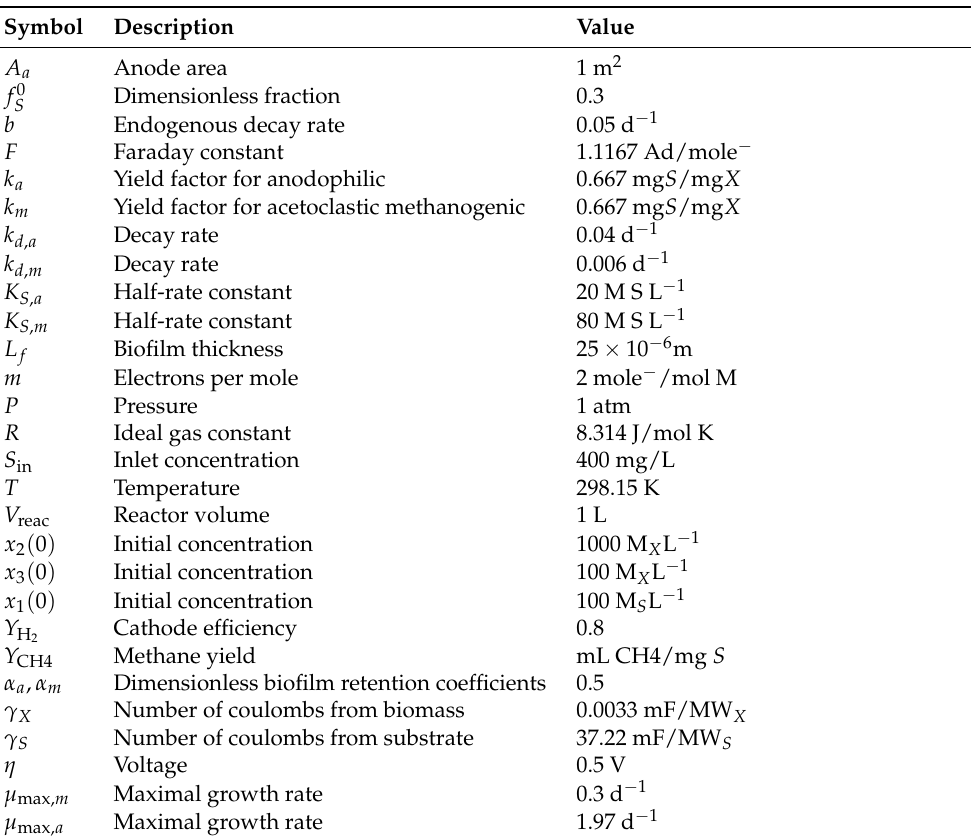
Table 3. Process parameters and their nominal